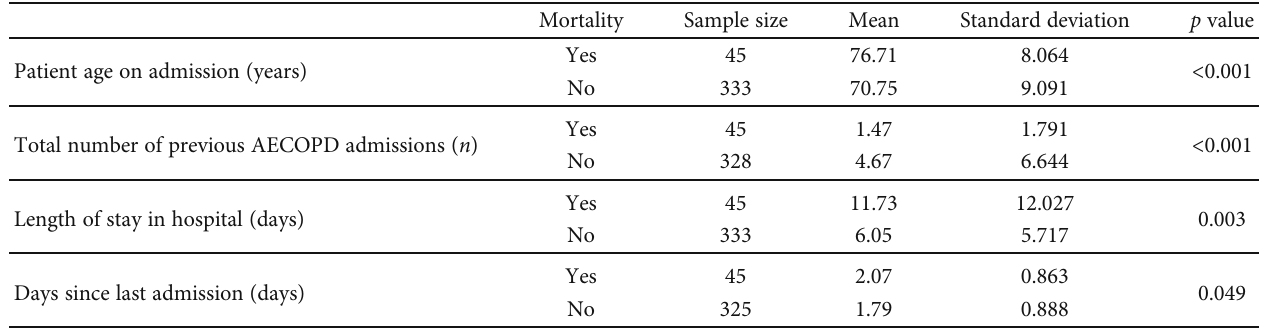
Table 4: Continuous variables signi fi cantly related with inpatient mortality (analysed using independent samples t -test).